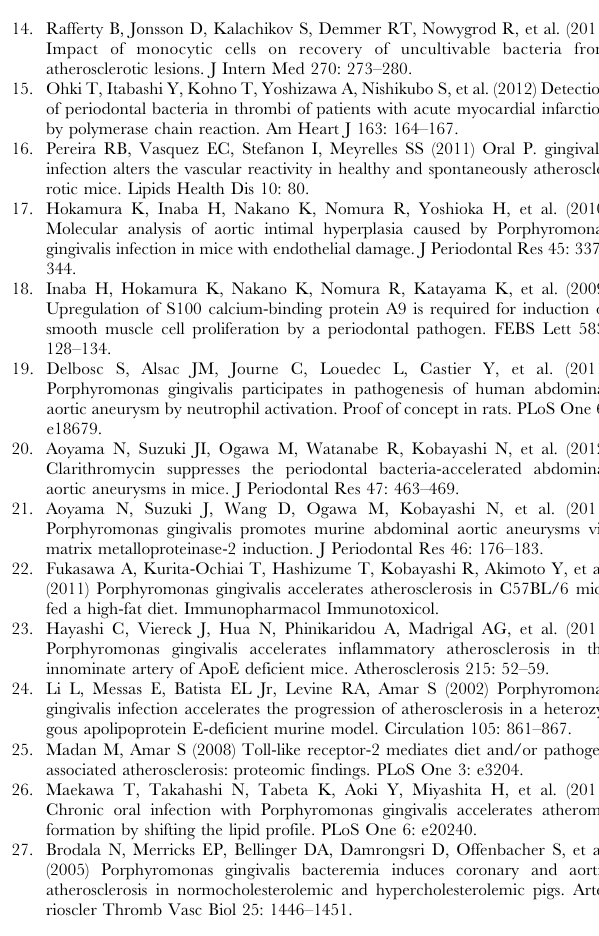
Figure S3 Representative microscopic images of fed uninfected HCAE cells (HCAEC) and HCAE cells infected with P. gingivalis strains A7436, 381, and 33277 within LC3 positive vacuoles. Cells were processed at 6 hours post- inoculation. Arrows indicate bacteria within LC3 positive vacuoles. Scale bar is equivalent to 10 m m. Figure S4 Representative microscopic images of P. gingivalis strains A7436, 381, and 33277 within LAMP-1 positive vacuoles at 6 hours post-inoculation. Arrows indicate bacteria within LAMP-1 positive vacuoles. Scale bar is equivalent to 10 m m. Figure S5 Inhibition of autophagy with 3-MA. At 48 hours post-transduction with Ad-GFP-LC3 (MOI 10), transduced cells infected were pre-treated with 10 mM 3-MA one hour prior to infection with P. gingivalis 381, which was added at an MOI of 100. Treatment with 3-MA was maintained in infected cultures until time of harvest (6 hours post inoculation). Harvested cells were processed and imaged as described in the methods section. Figure S6 Assessment of HCAE cell viability and toxicity after infection with P. gingivalis. Representative images of uninfected (A) and P. gingivalis strain W83 infected (B) HCAE cells at 24 hours post-inoculation. Images were obtained at 200 6 magnification (scale bar= 100 m m). Cell viability was evaluated